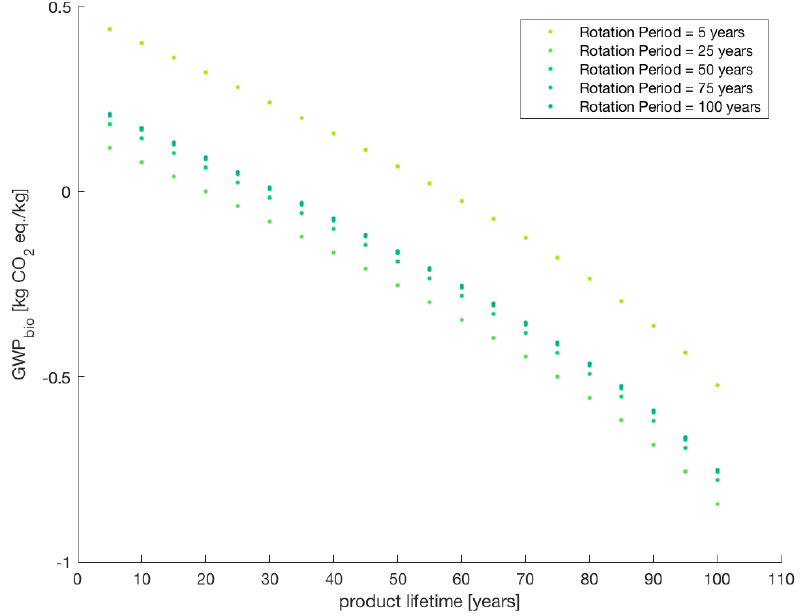
Figure 3. Overlay plot of curves representing the evolution of GWP bio with respect to product life- for various biomass rotation time for various biomass rotation period.